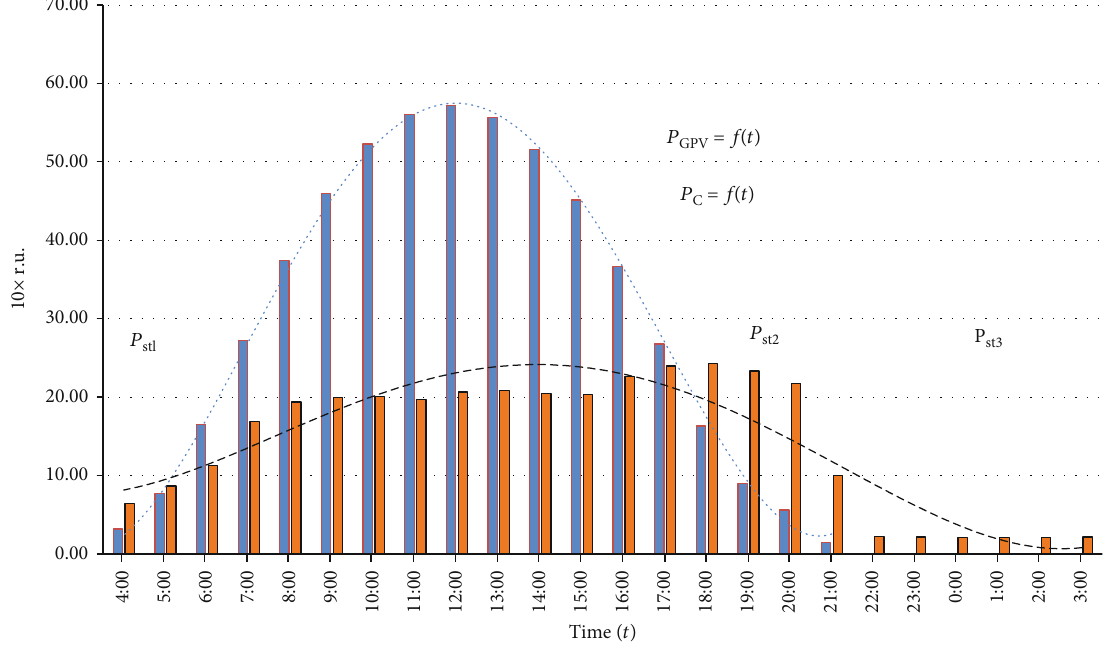
Figure 12: Representation of areas to be